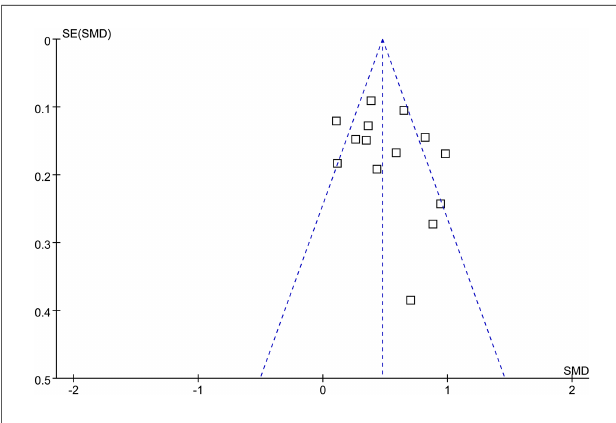
FIGURE 3 Funnel plots for the publication bias underlying the meta-analysis for the difference of serum LDH between children with severe and non-severe